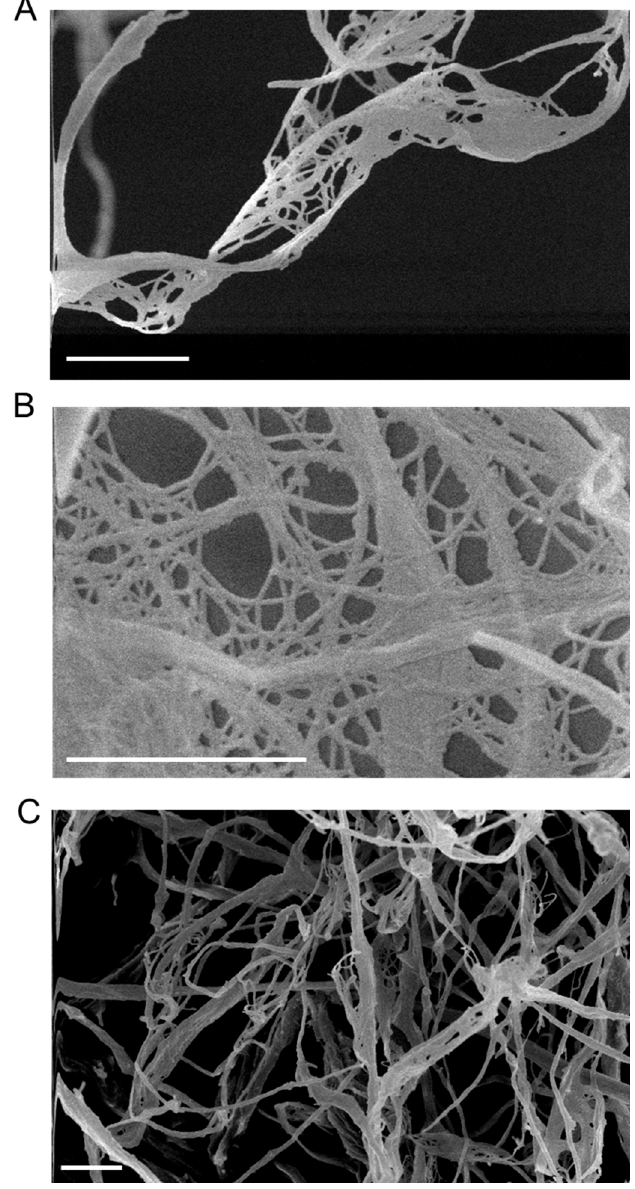
Figure 1. SEM images of O-MFC ( A ), P-MFC ( B ) and E-MFC ( C ), respectively. The scale bars refer to 1 µm.